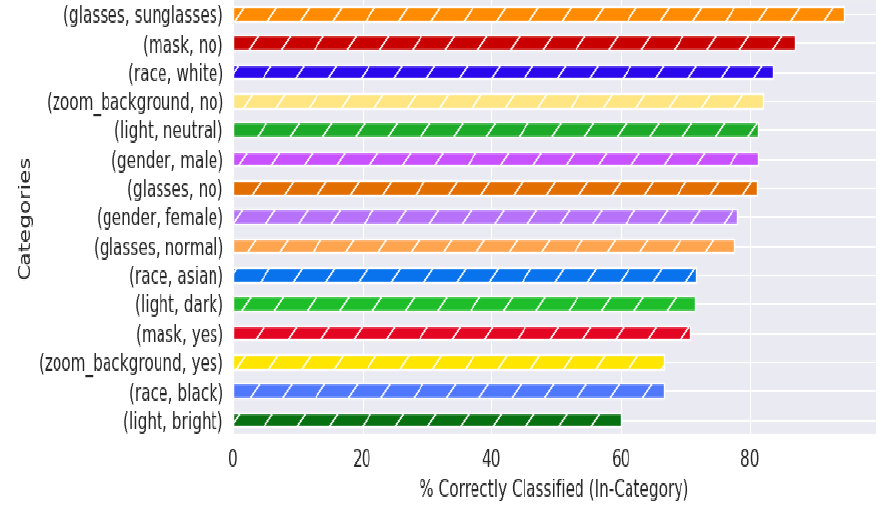
Figure 8. ‘Good’ (qualitative) quality image test performance with augmented MobileNetv2 model across categories. Plot of categorical labels and classification performance with qualitative quality evaluation.